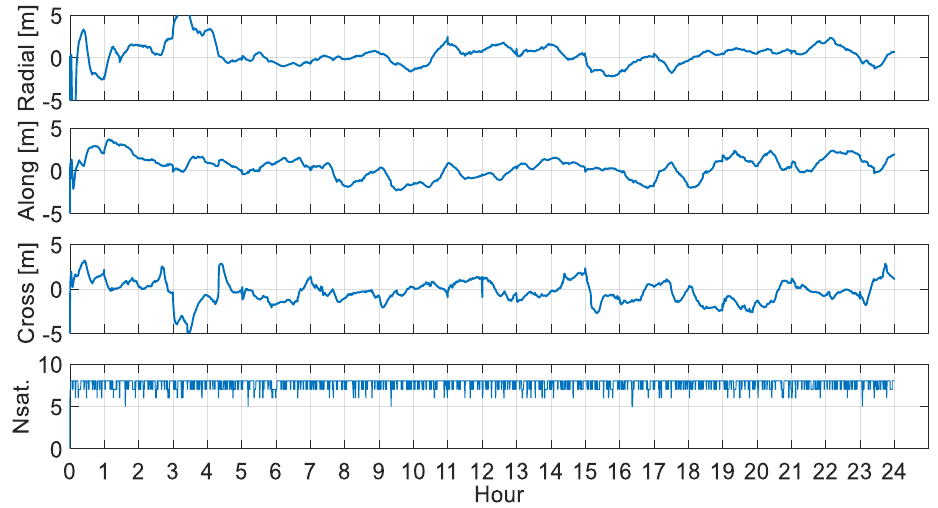
Figure 2. Swarm-A real-time POD results on a normal day of Scheme 1.